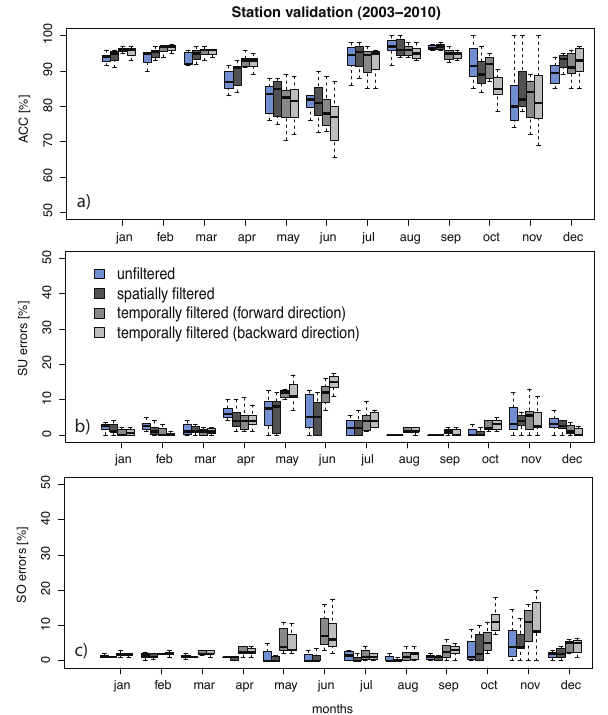
Fig. 4. Monthly median and Inter Quartile Range (IQR) of (a) ACC, (b) SU error, and (c) SO error from station validation for the period 2003–2010. Different colors refer to different types of filtering procedures (see legend).